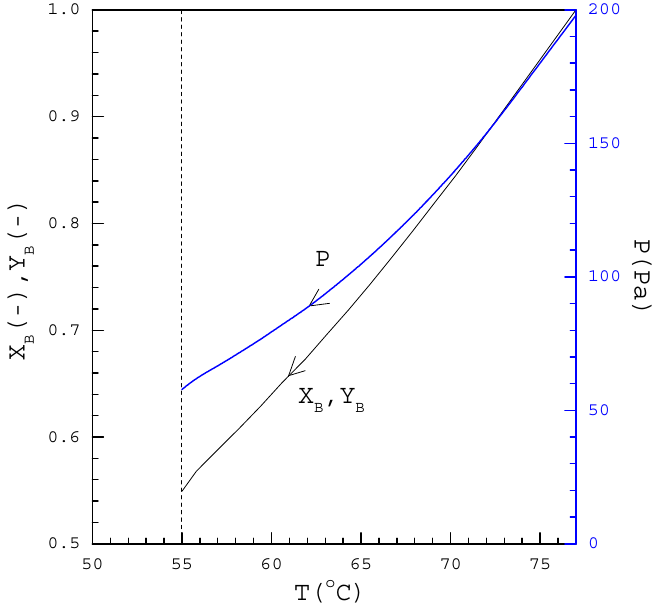
Figure 2. P(T), X B (T) and Y B (T) based on the thermodynamic calculations for the three-phase transformation.